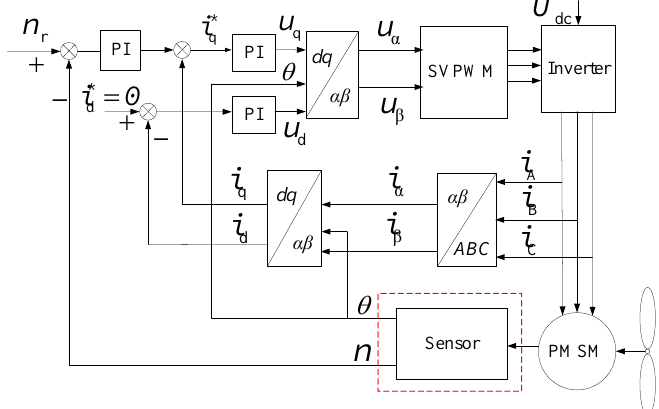
Figure 2. Vector control system of a permanent magnet synchronous motor (PMSM) applied in ships.